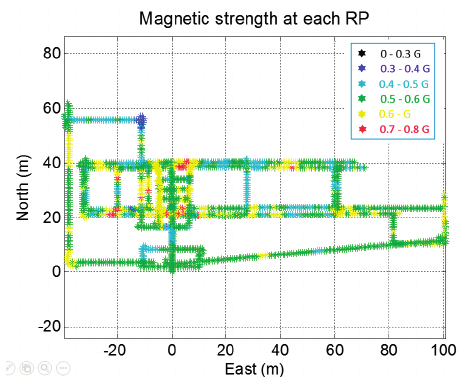
Figure 6. Magnetic distribution at